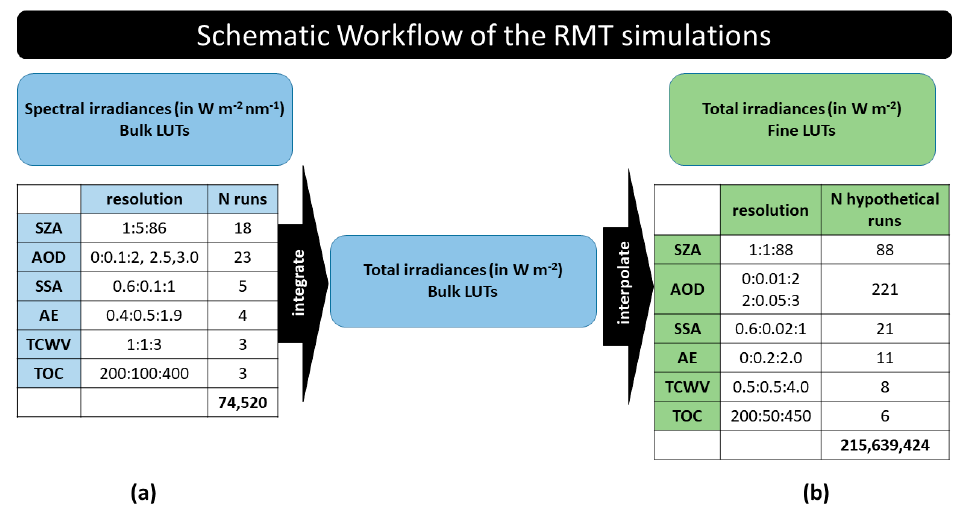
Figure 2. Schematic workflow of the RTM simulations. ( a ) The resolution of the input parameters used for simulating spectral global and direct irradiances using uvspec. ( b ) The final resolution of the fine look-up tables (LUTs) of clear-sky total global and direct irradiances after interpolating to all dimensions. Table 2. The different experiments for which DSSI values were extracted from the fine